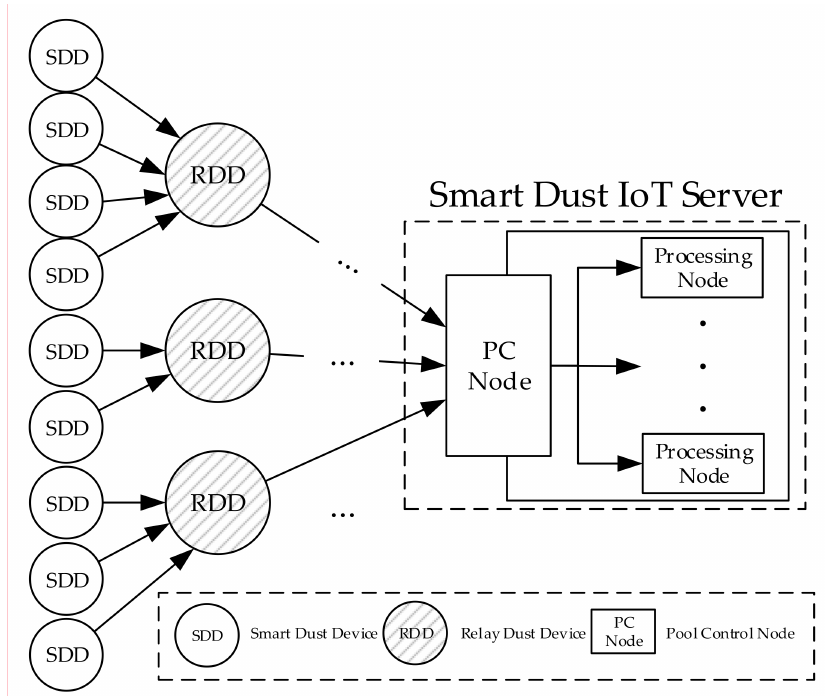
Figure 1. An overview of physical devices in a smart dust IoT environment